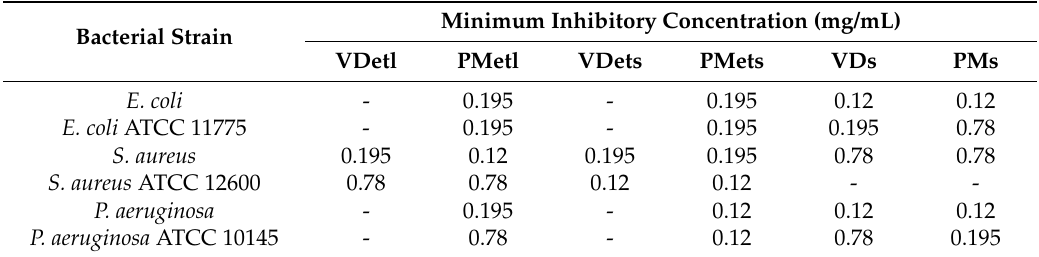
Table 4. Minimum inhibitory concentration (MIC) of the plant extracts against test organisms. Minimum Inhibitory Concentration (mg/mL) Bacterial Strain VDetl PMetl VDets PMets VDs PMs E. coli - 0.195 - 0.195 0.12 0.12 E. coli ATCC 11775 - 0.195 - 0.195 0.195 0.78 S. aureus 0.195 0.12 0.195 0.195 0.78 0.78 S. aureus ATCC 12600 0.78 0.78 0.12 0.12 - - - 0.195 - 0.12 0.12 0.12 P. aeruginosa ATCC 10145 - 0.78 - 0.12 0.78